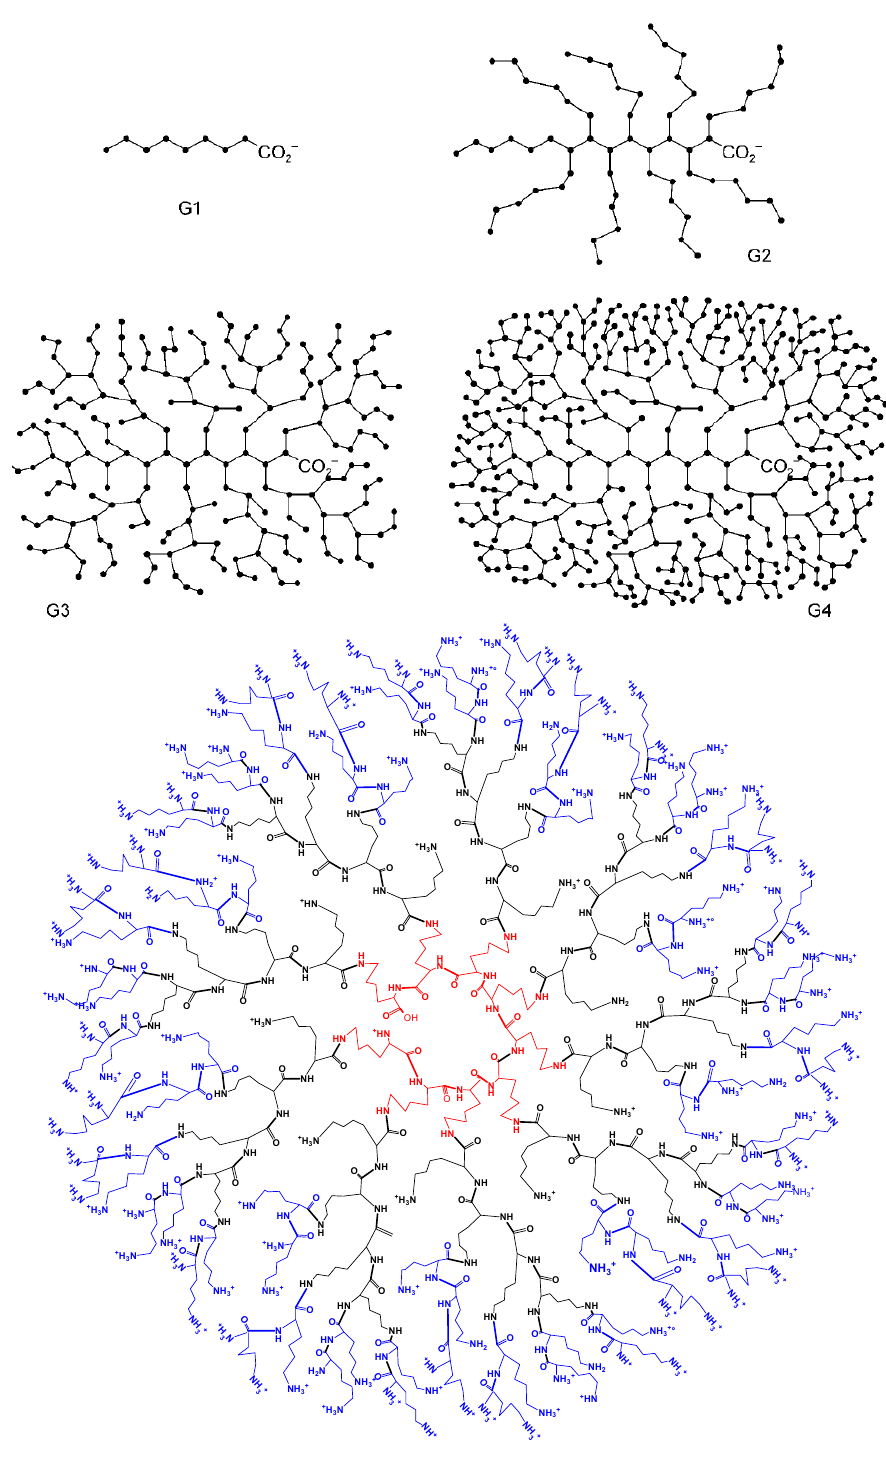
Figure 1. Schematic representation of the four first generations of dendrigraft poly-L-lysines (DGL) and typical chemical structure of DGL G3. Each dot represents a Lys residue. Chemical structure in red corresponds to G1. Chemical structure in red and blue corresponds to G2. The central part of the G3 structure is depicted in a cyclic conformation to facilitate the 2D-representation of the whole